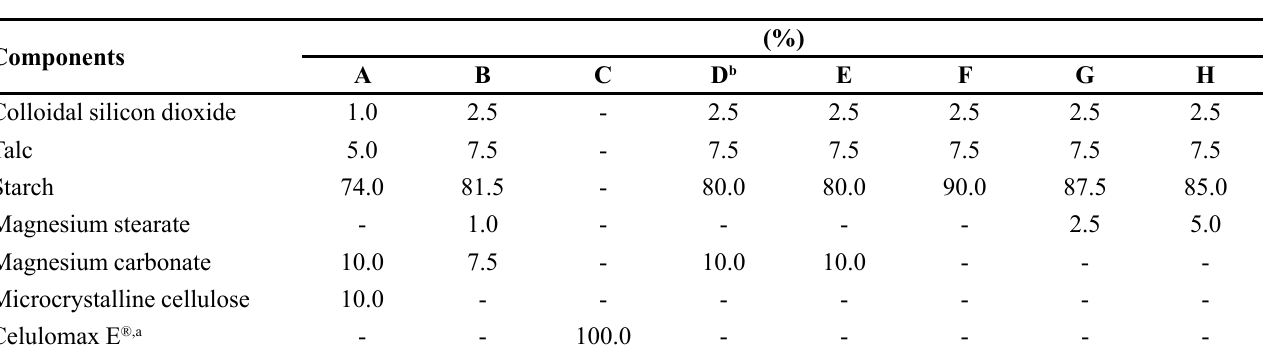
TABLE I - Composition of the ROSC formulations